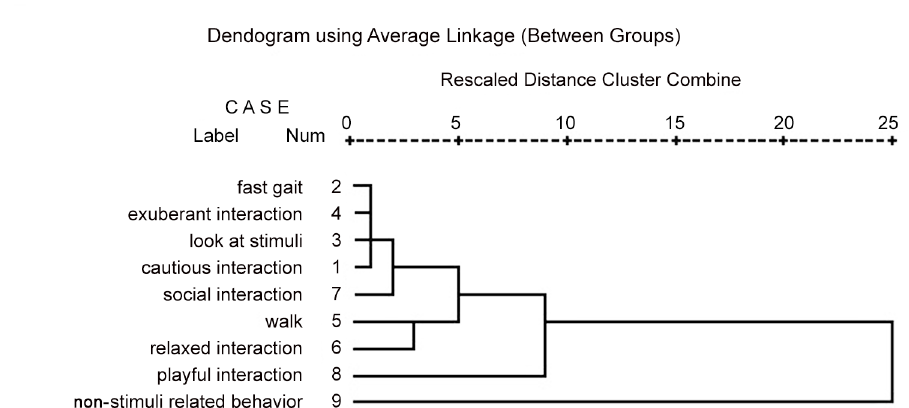
Fig 2. Behaviours hierarchical cluster analysis: agglomeration